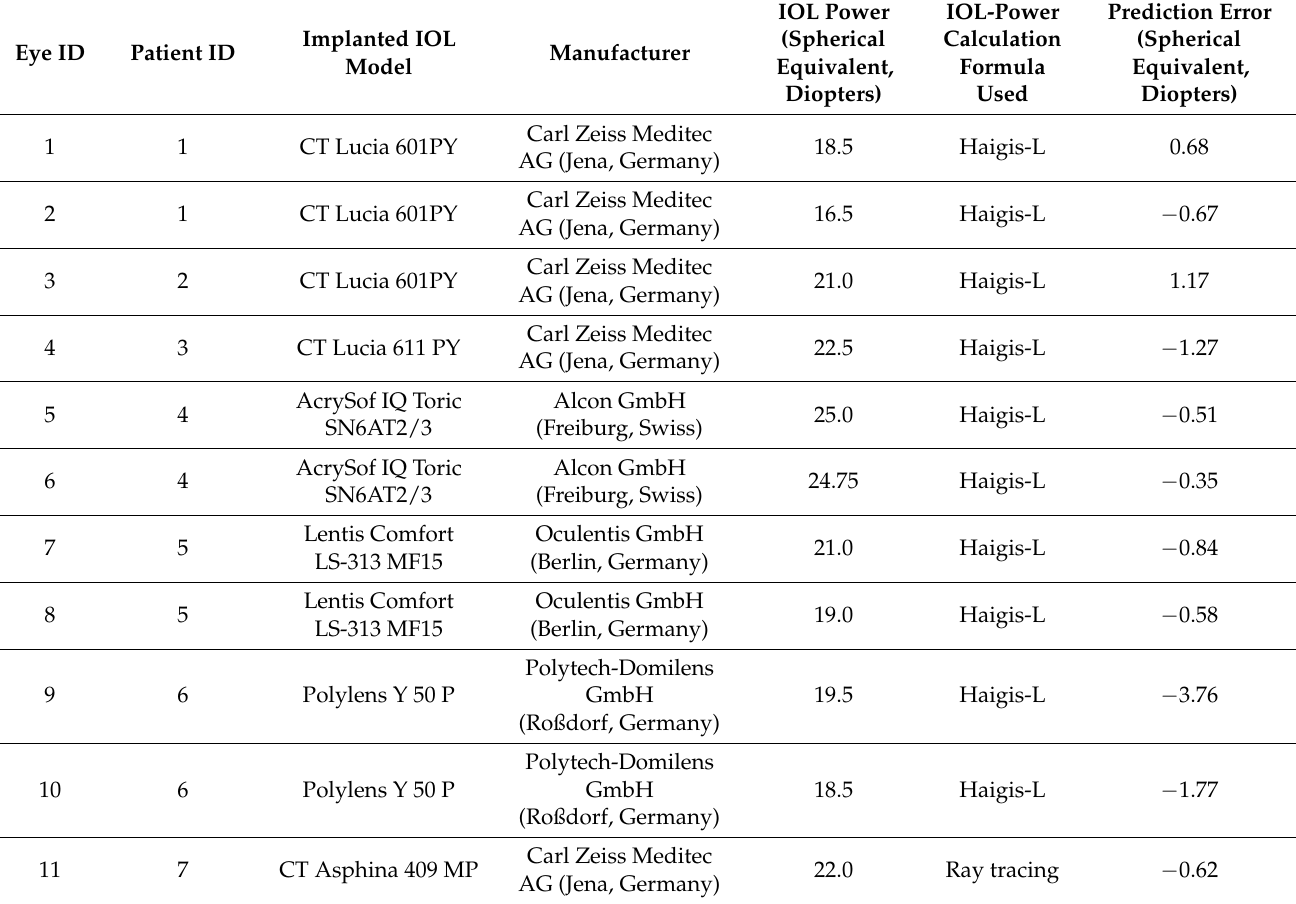
Table 1. Implanted IOL models, powers and observed prediction